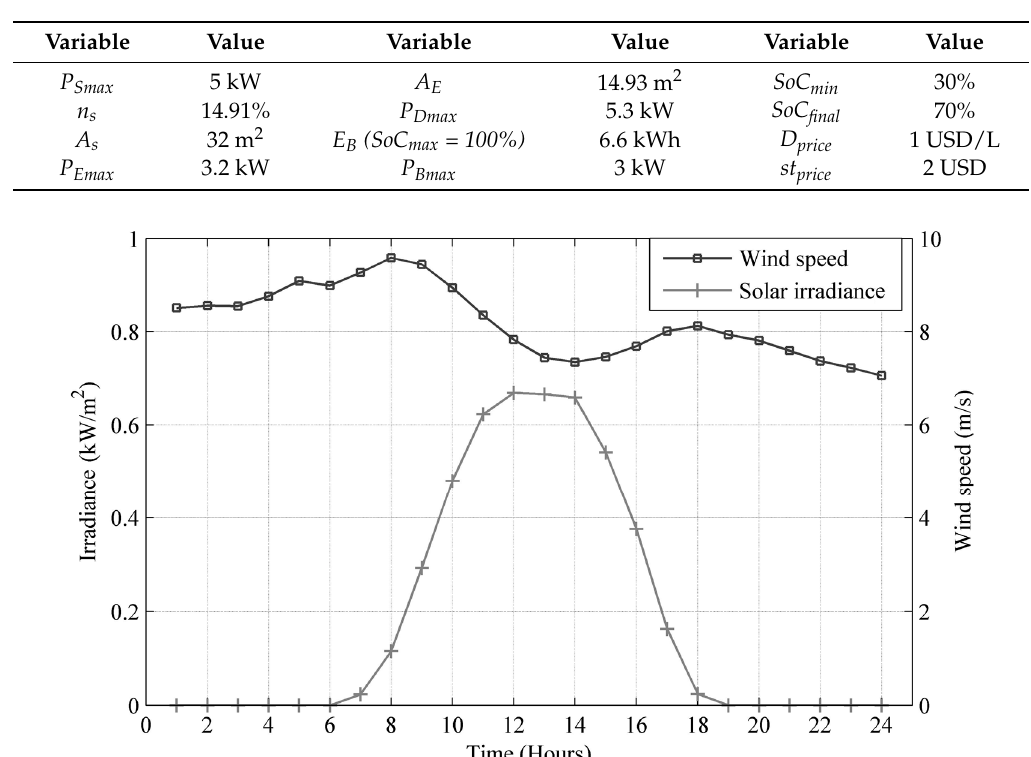
Figure 4. Energy availability of Taroa, La Guajira, Colombia.